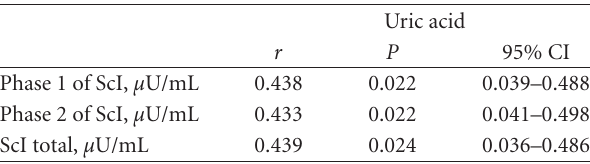
Table 4: Correlation between uric acid and insulin secretion phases adjusted by body mass